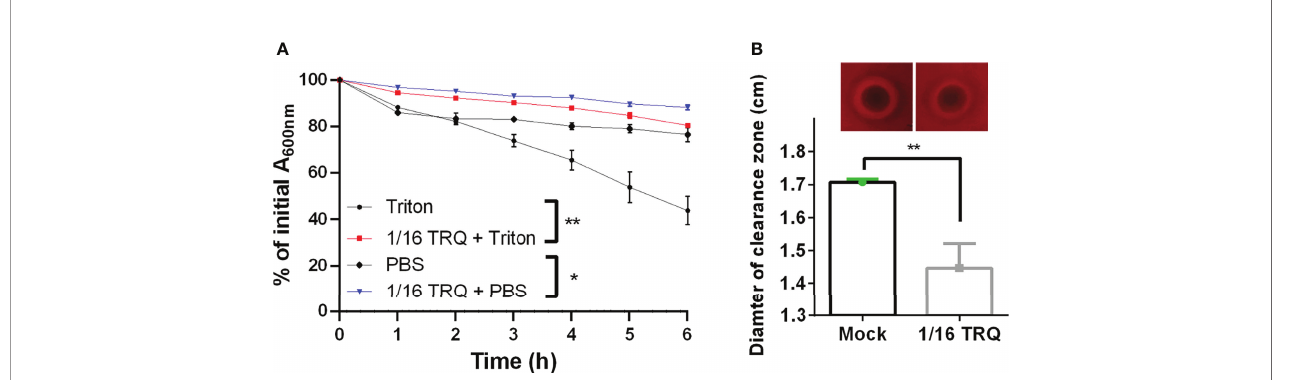
FIGURE 3 | TRQ attenuates autolysis and hemolysis in S. aureus . (A) Effect of the TRQ (1/16 dilution) on Triton X-100 induced autolysis. The autolysis activity with and without 0.05% Triton X-100 was monitored by measuring OD 600 over time. PBS control group also showed a similar trend compared to that of Triton X-100 treatment. The experiment was performed three times. Error bar represents the mean ± SD. * P < 0.05; ** P < 0.01. (B) Hemolysis on sheep blood agar. S. aureus strains tested with TRQ (1/16 dilution) were spotted on a 5% (v/v) sheep blood agar plate. Clearance zones indicate hemolysis and were measured. The experiment was performed three times. Error bar represents the mean ± SD. ** P <